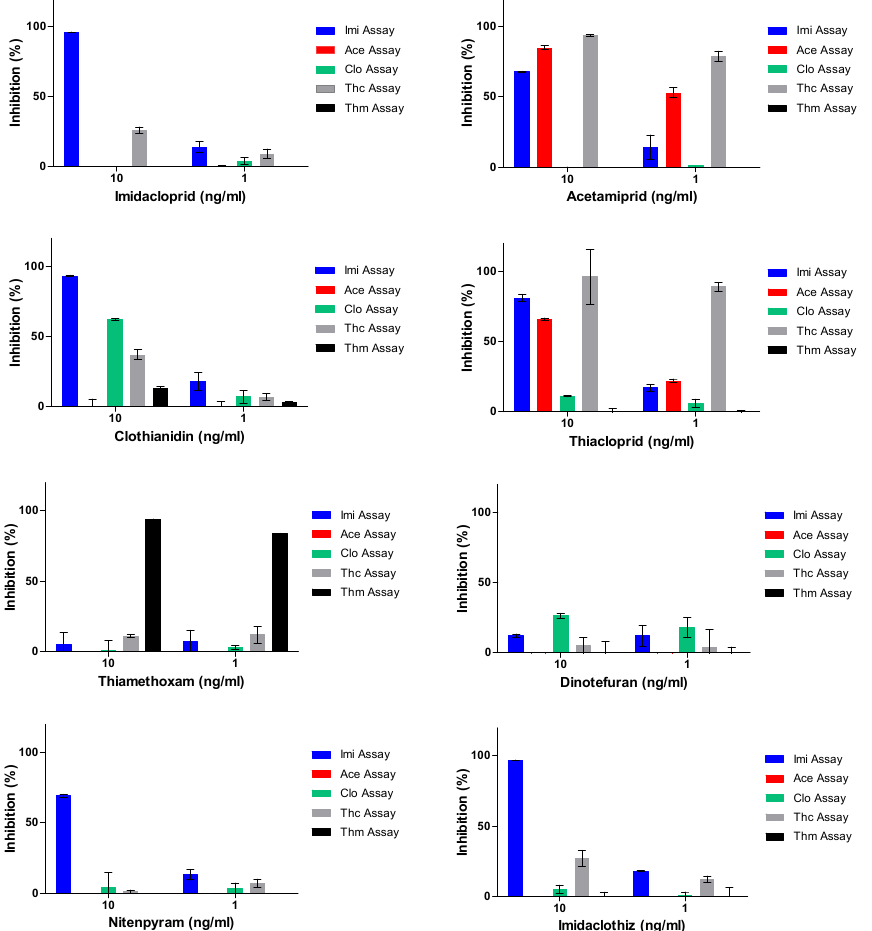
Figure 4. Inhibition profiles of the eight neonicotinoids in tap water at 10 and 1 ng/mL in the five neonicotinoid profiling assays (nMIAs) ( n = 2).